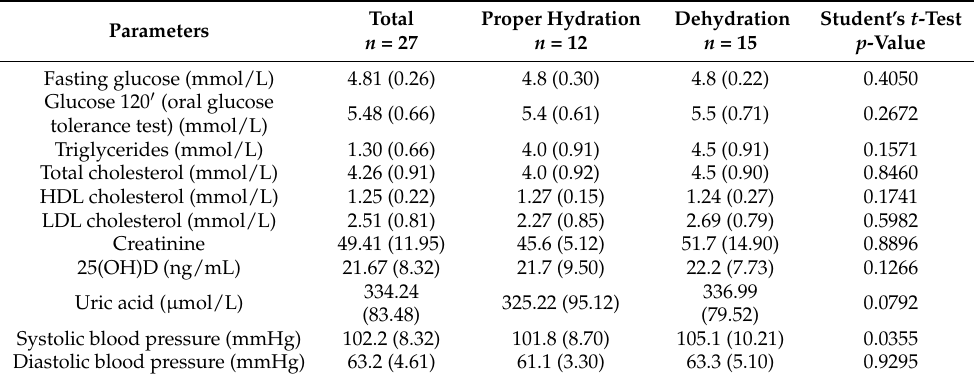
Table 3. Metabolic parameters and blood pressure in the study group, depending on the hydration level.